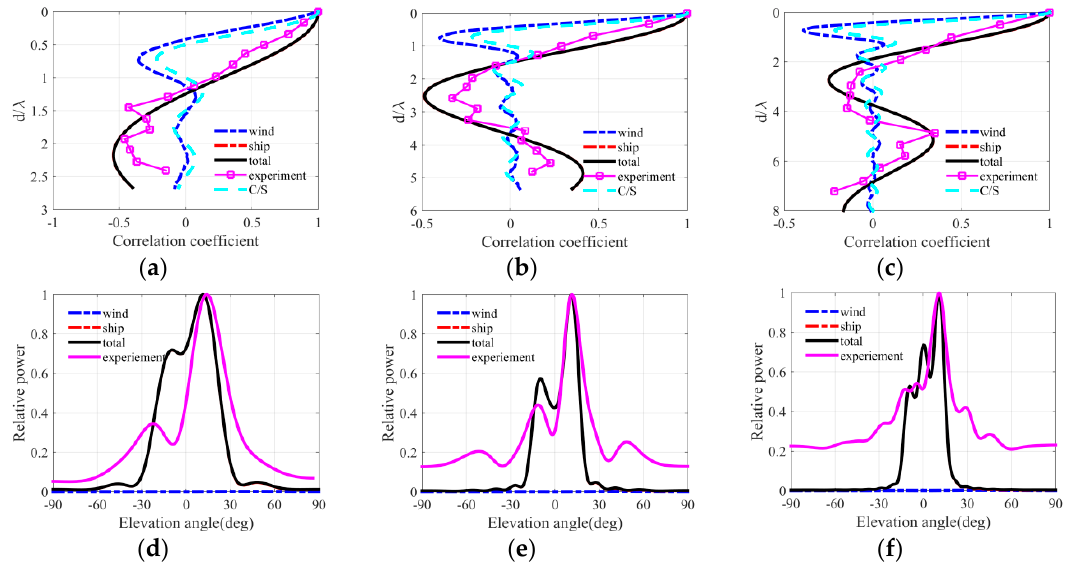
Figure 16. Vertical correlation coefficient and directionality at 3:00, 20 August for frequencies of ( a , d ) 50 Hz, ( b , e ) 100 Hz and ( c , f ) 150 Hz.